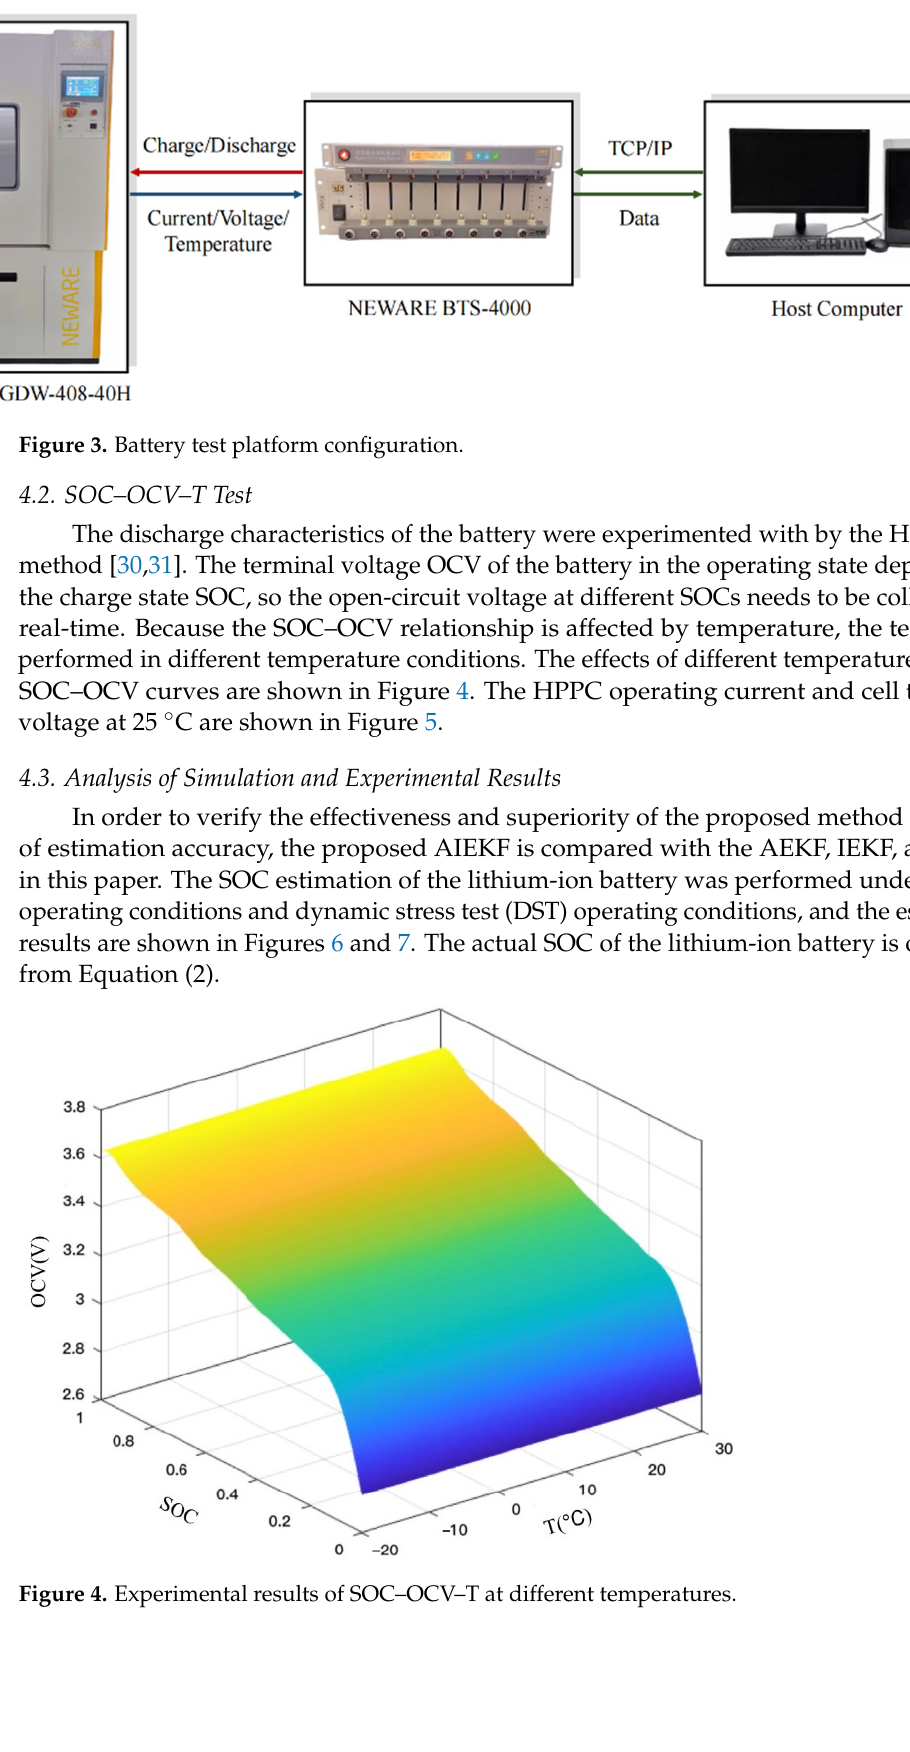
Figure 4. Experimental results of SOC–OCV–T at different temperatures.